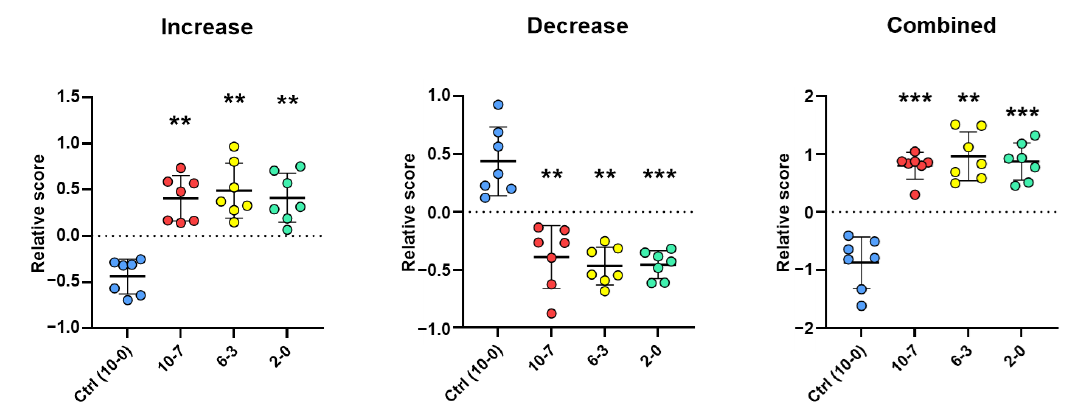
Figure 9. Relative score by period. The plots show the relative scores (Y-axis) for each of the seven NEC samples (red, yellow and green dots) of the three tested periods (X-axis: 10-7, 6-3, 2-0 days before NEC diagnosis) compared to the average of the three same periods for the non-NEC control samples (Ctrl: 10-0 days; blue dots) to assess the overall relative scores for samples from NEC and non-NEC infants without pairing. The (Increase) and (Decrease) plots were calculated from the 18 increased and the 18 decreased protein markers taken separately, and the (Combined) plot combines the mean values of these two plots for each sample (increased + decreased; multiply by − 1). The means ± SD are shown on the plots by horizontal bars. p -values were calculated using one-way ANOVA Dunnett’s multiple comparisons test. ** p < 0.01; *** p < 0.001.